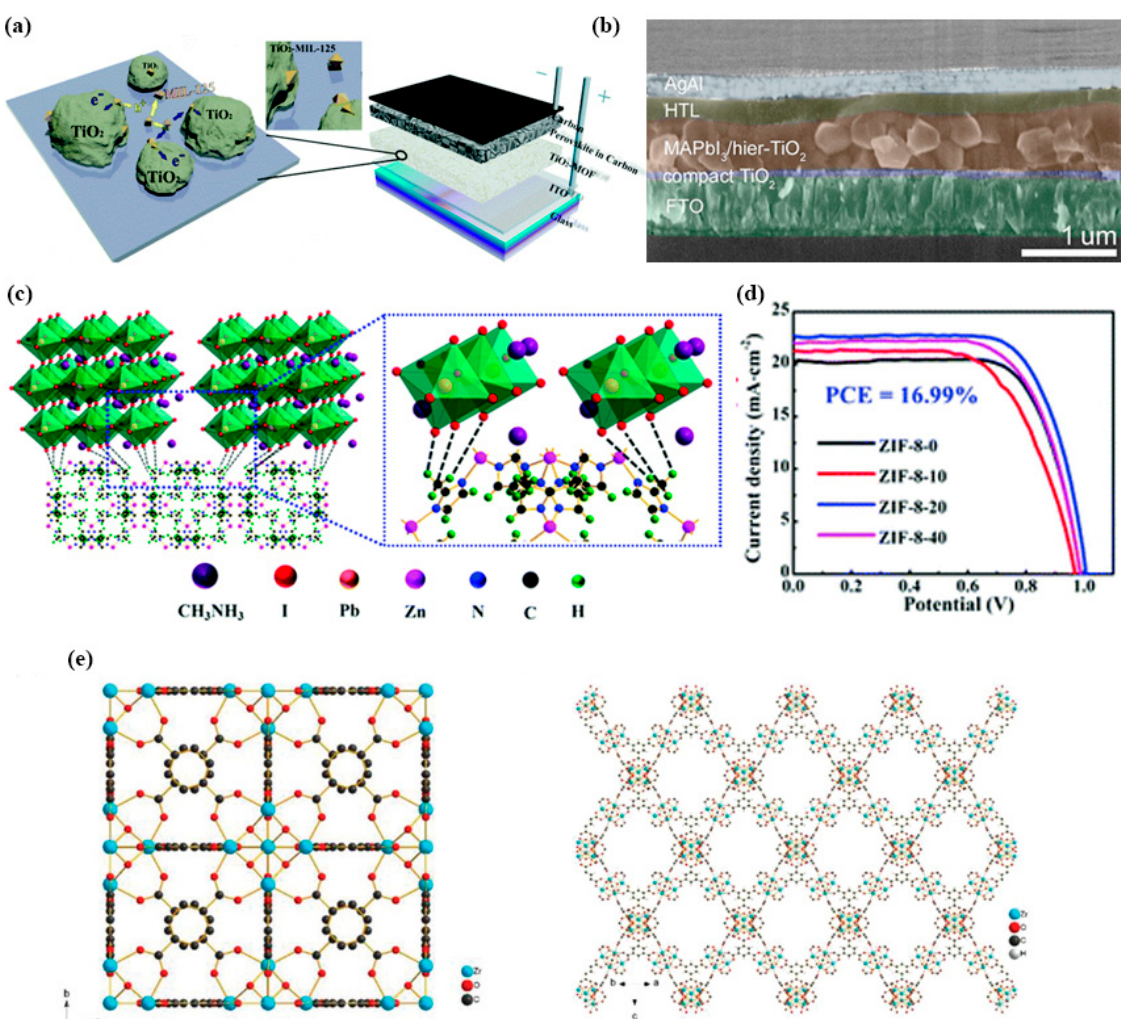
Figure 3. ( a ) Diagram structure of the photoactive composite and the depleted quasi-bulk heterojunction structure of TiO 2 -MIL-125 [54]. ( b ) Cross-sectional SEM of quasi-mesoscopic PSC using hier-TiO 2 deposited on compact TiO 2 layer [52]. ( c ) Schematic description of two adjacent grain structures linked by methyl groups of ZIF-8. ( d ) J-V curves of PSCs with ETLs containing ZIF-8-coated mp-TiO 2 for various times [19]. ( e ) The crystal structures of UiO-66 ( left ) and MOF-808 ( right ) [55].